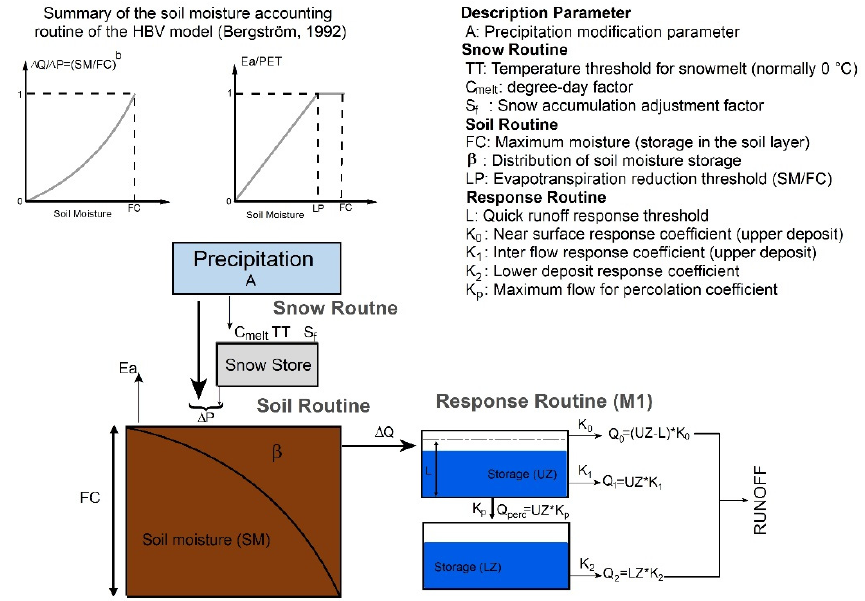
Figure 2. General conceptual diagram of the simplified HBV model, including a description of its parameters and main equations.